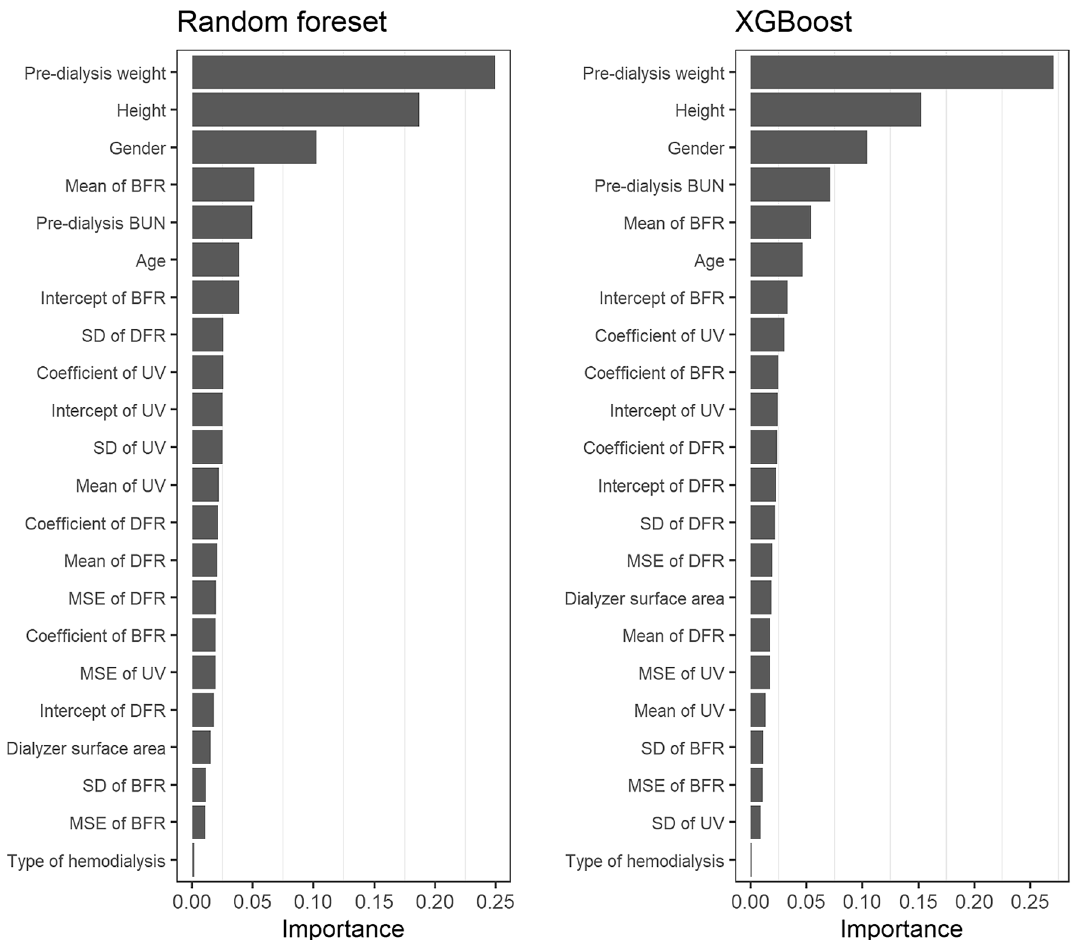
Figure 2. Random forest and XGBoost feature importance plots. XGBoost extreme gradient boosting, MSE mean squared error, SD standard deviation, BFR blood flow rate, DFR dialysate flow rate, UV ultrafiltration volume.